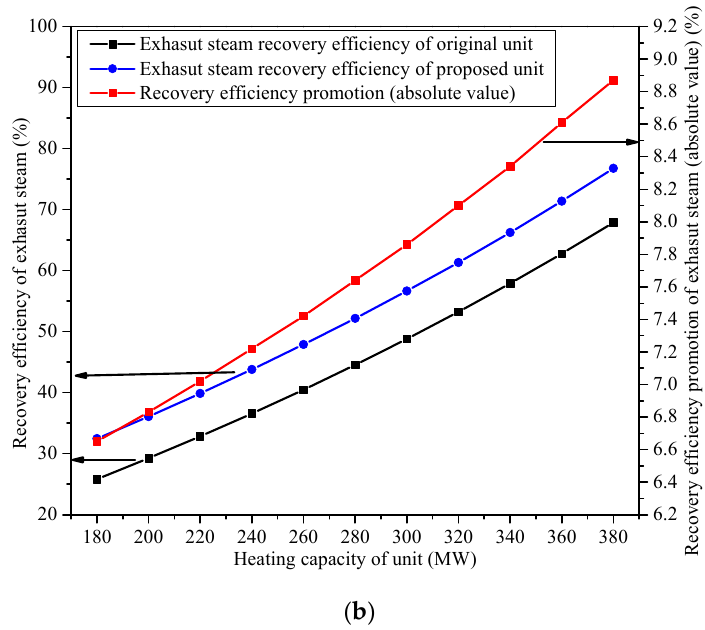
Figure 6. Impact of the unit heating capacity on the performance of the proposed design: ( a ) Total raw coal consumption of unit; and ( b ) recovery efficiency of the exhaust steam.